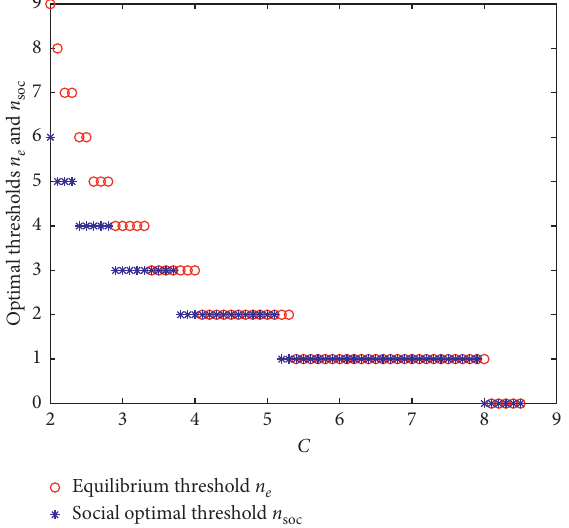
Figure 5: Equilibrium and social optimal joining probabilities versus C ( R s � 4 , R f � 1 , λ � 1 . 5 )